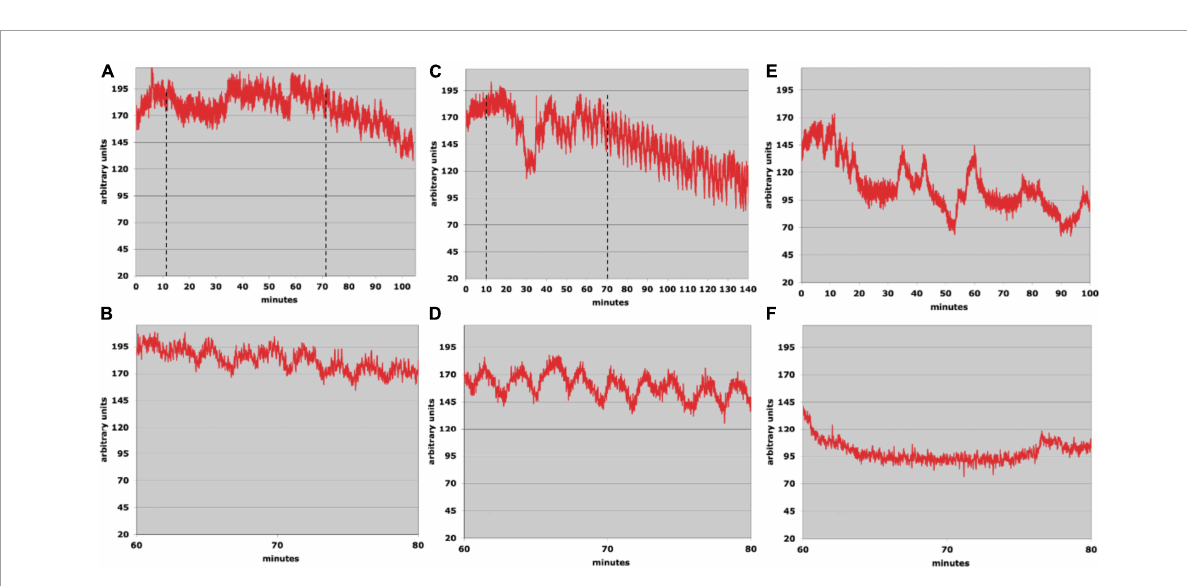
FIGURE4 (A,C) Laser Doppler flowmetry data; the dotted lines show the start and stop times of the time-varying caloric vestibular stimulation (tvCVS) stimulation. (B,D) Expanded views of the oscillations from panels (A,C) . (E,F) Control